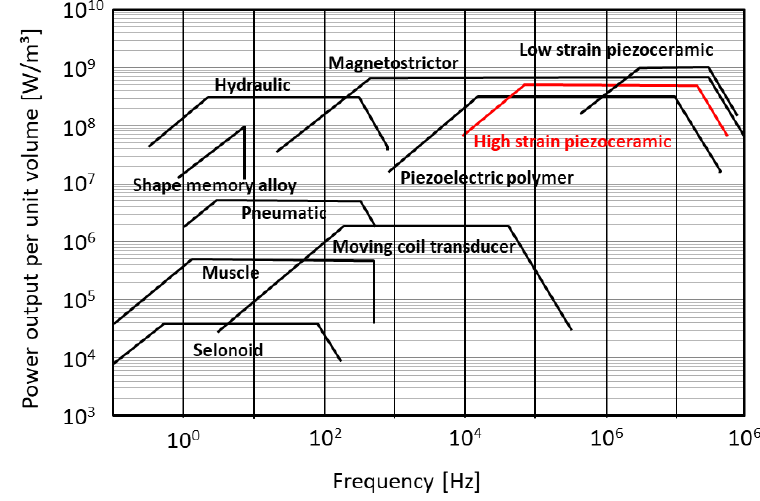
Figure 3. Comparison of different actuators by means of power output per unit volume and operation frequency (the data were taken from [14]).